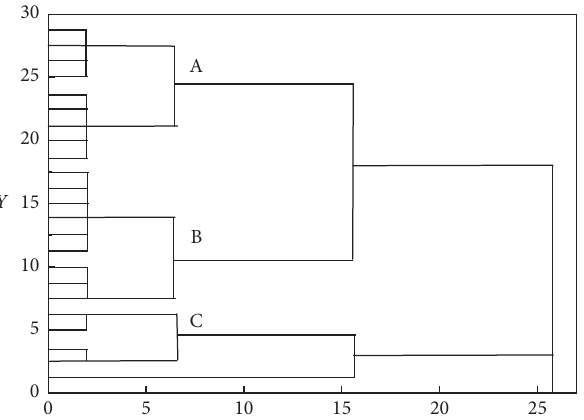
Figure 6: Horizontal clustering tree diagram.